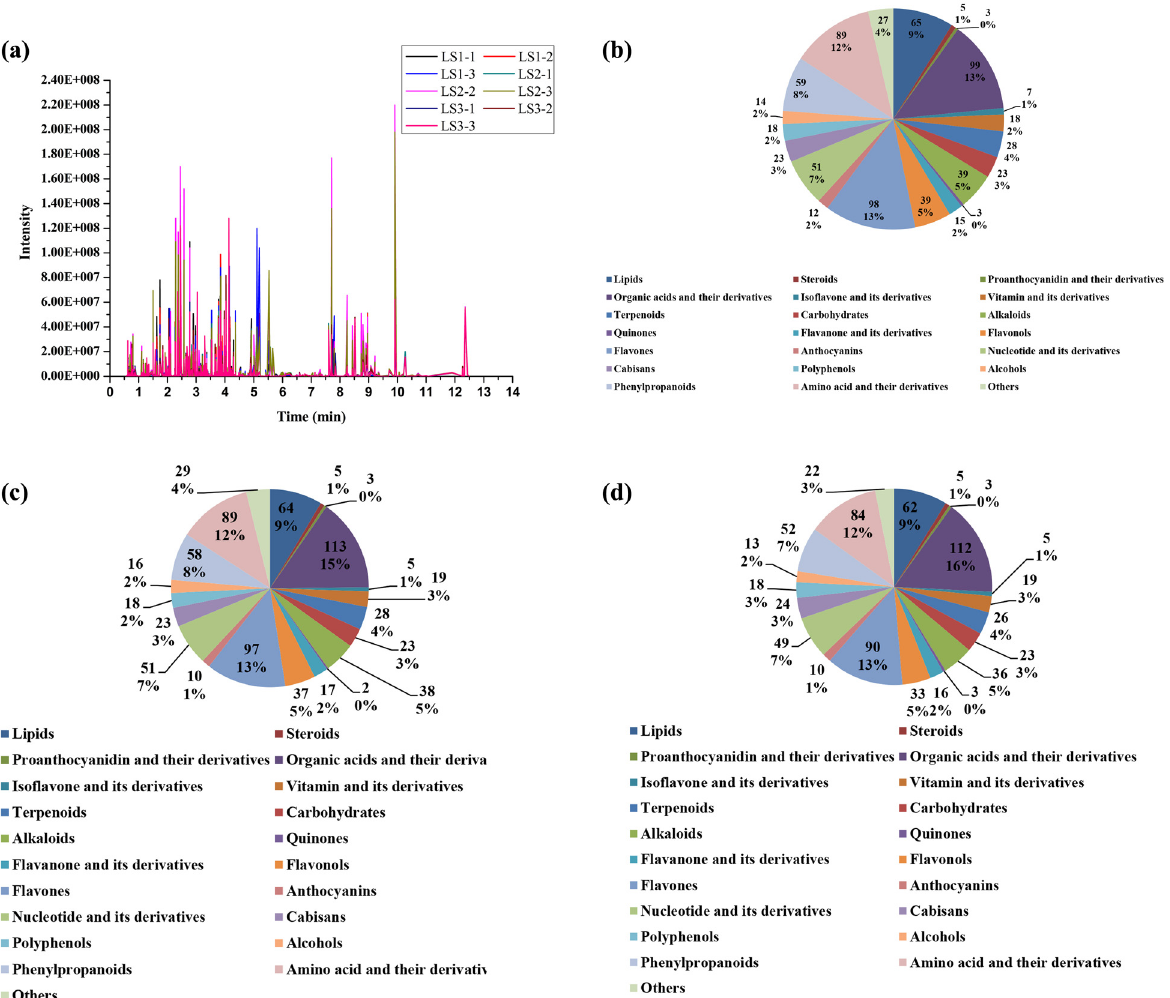
Figure 2: Total ion chromatogram of metabolites ( a ) and the identi fi ed metabolites from the LS1 ( b ) , LS2 ( c ) , and LS3 ( d ) at three di ff erent foliar ages of jujube